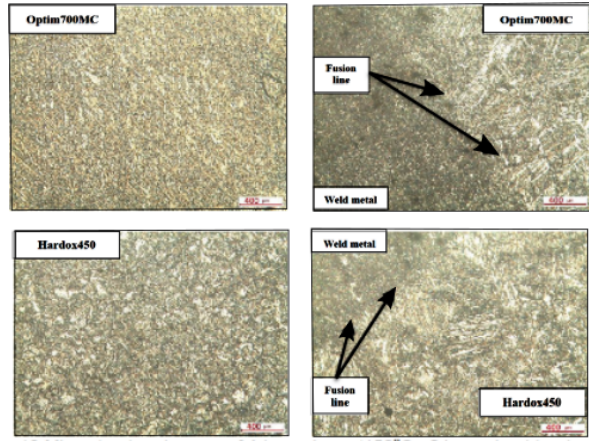
Figure 12: The microstructure of A1 specimen (2 hours of heat treat- ment at 450 ∘ C). Reprinted with permission from Uzunali et al. // Advances in Structural Engineering and Mechanics, ASEM15 (2015). ©2015 ASEM15.